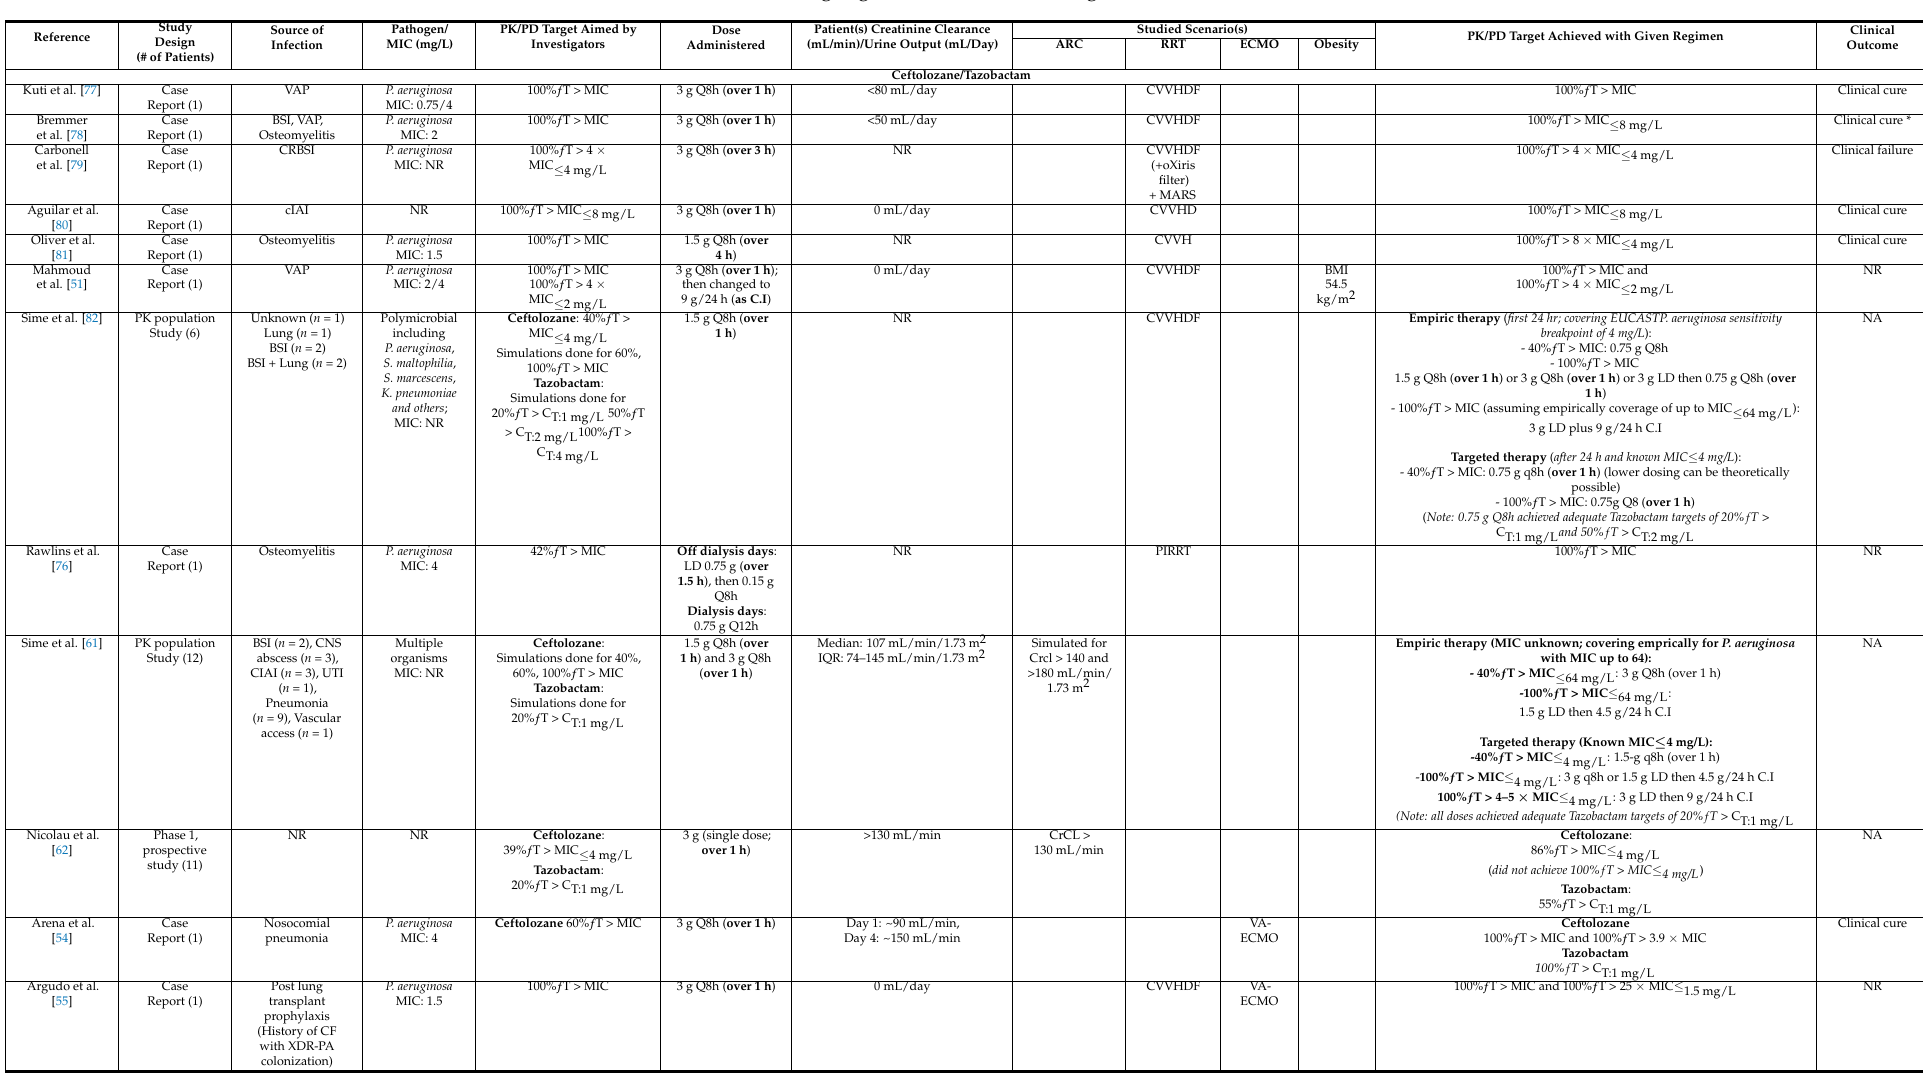
Table 2. Novel β -lactam antibiotics utilized dosing regimens and PK/PD target attained of in the included